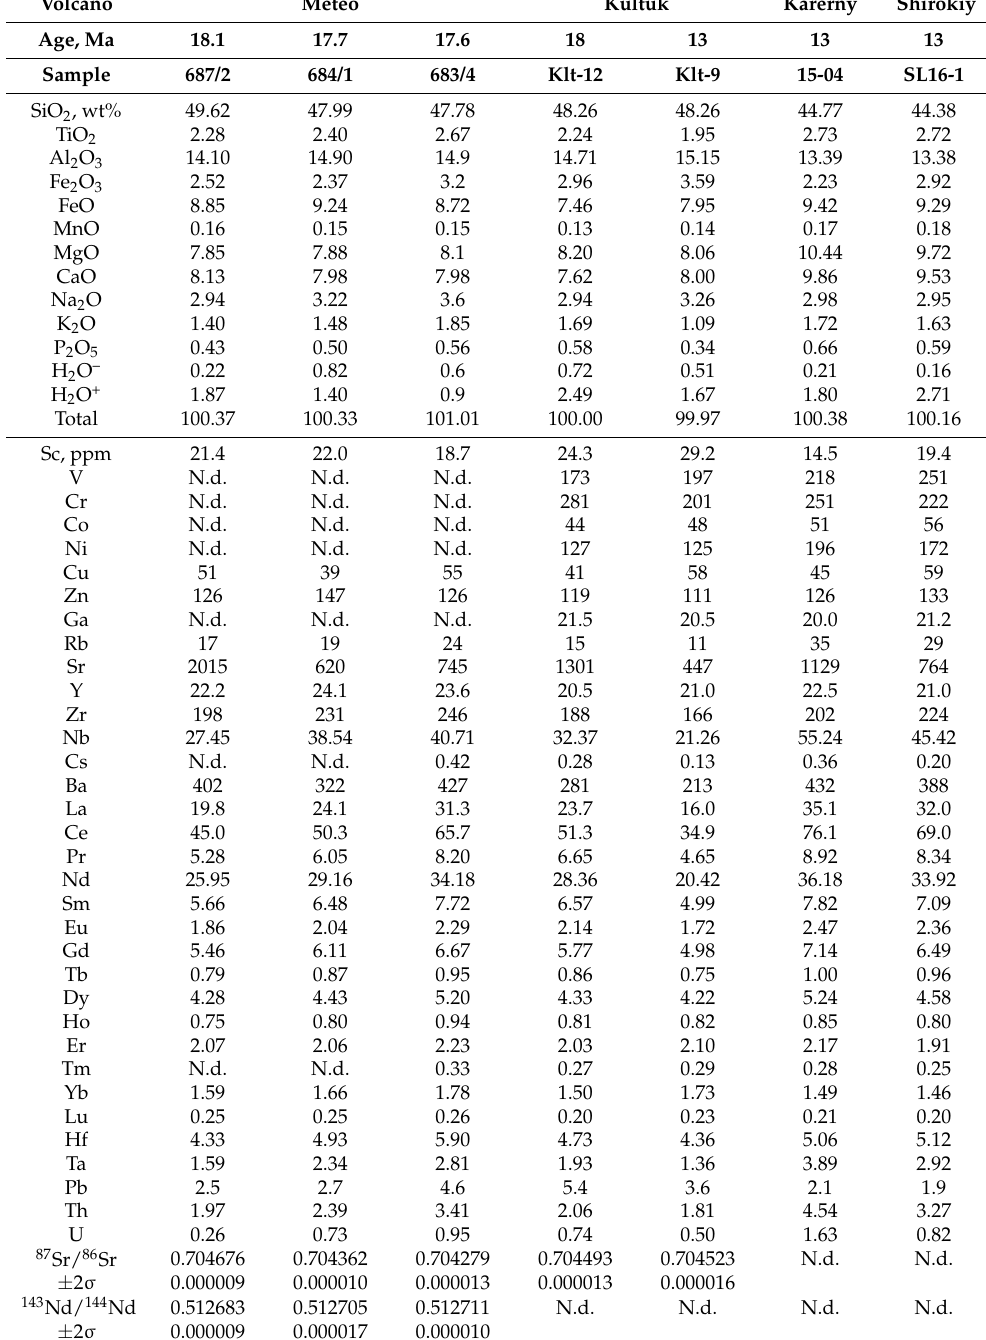
Table 2. Analytical results on representative samples of volcanic rocks from the KSZHT (Kamar- Stanovoy Zone of Hot Transtension). Volcano